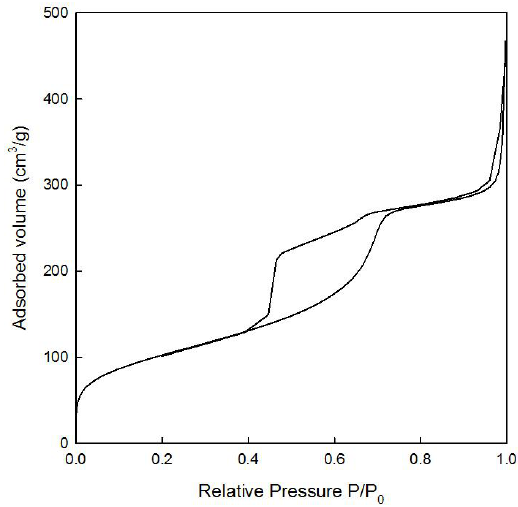
Figure 3. N 2 absorption-desorption isotherm of 5% TiO 2 -MAGSNC photocatalysts. P: partial vapor pressure of adsorbate gas in equilibrium with the surface at 77.4 K; P 0 : saturated pressure of adsorbate gas.